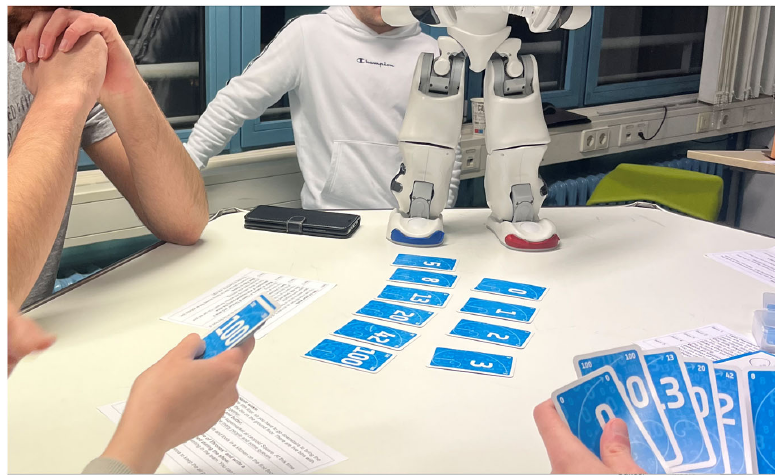
Figure 3. Materials used in the game “Planning poker with NAO”.